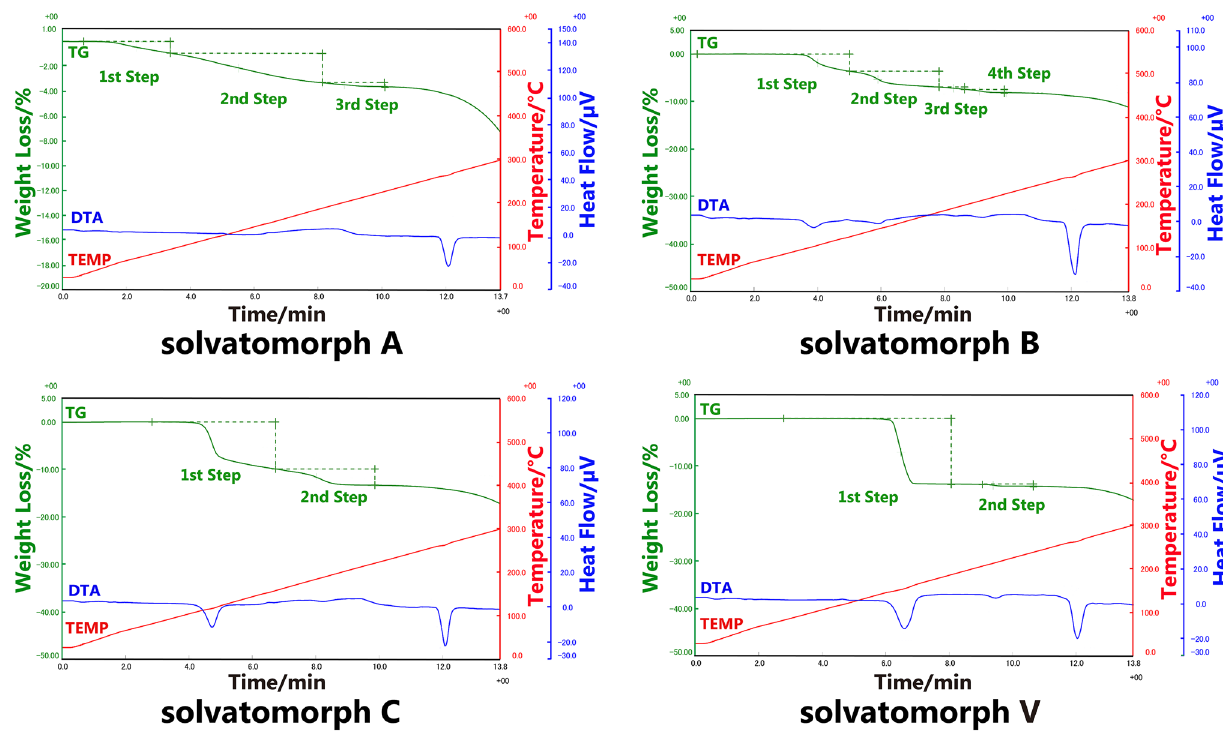
Fig. 1 TG, DTA and temperature curves of four solvatomorphs of